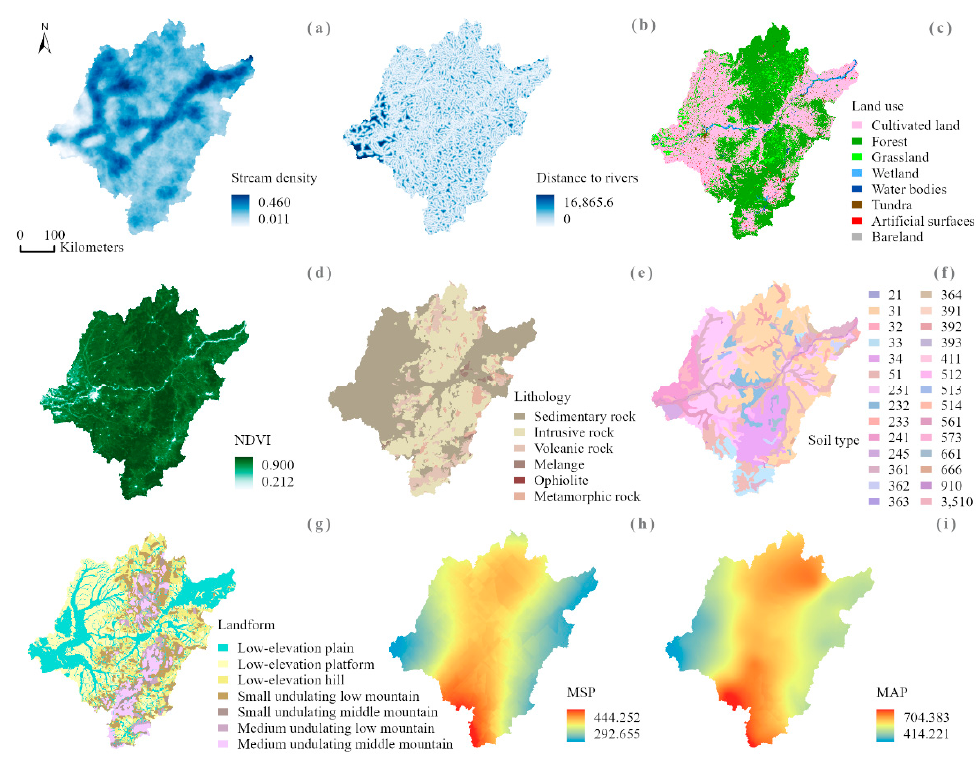
Figure 3. Maps of conditioning factors: ( a ) stream density, ( b ) distance to rivers, ( c ) land use, ( d ) NDVI, ( e ) lithology, ( f ) soil type, ( g ) landform, ( h ) MSP, and ( i ) MAP.